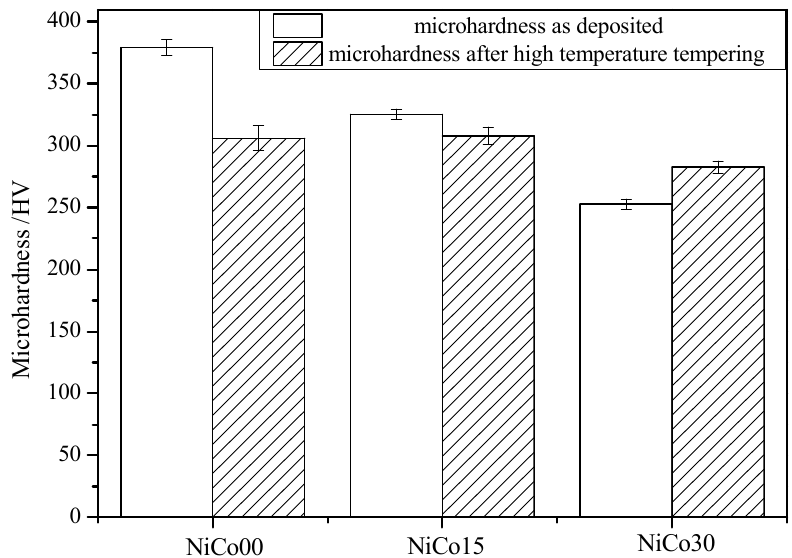
Figure 5. Microhardness of the cladding layers with different Co contents.